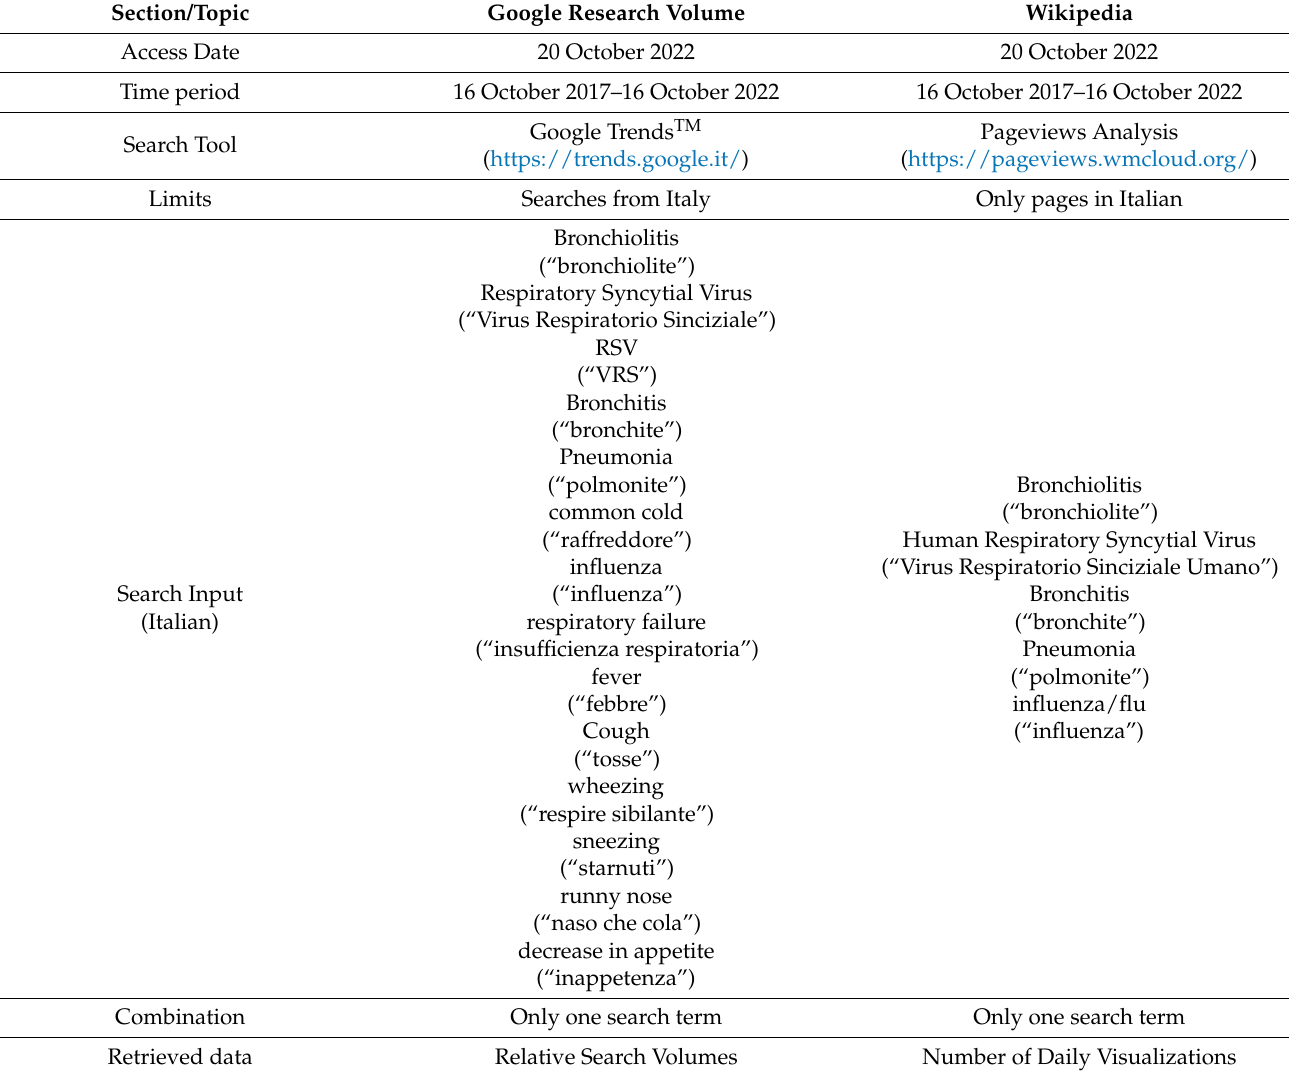
Table 1. Checklist for analysis of Google Research Volumes and Wikipedia